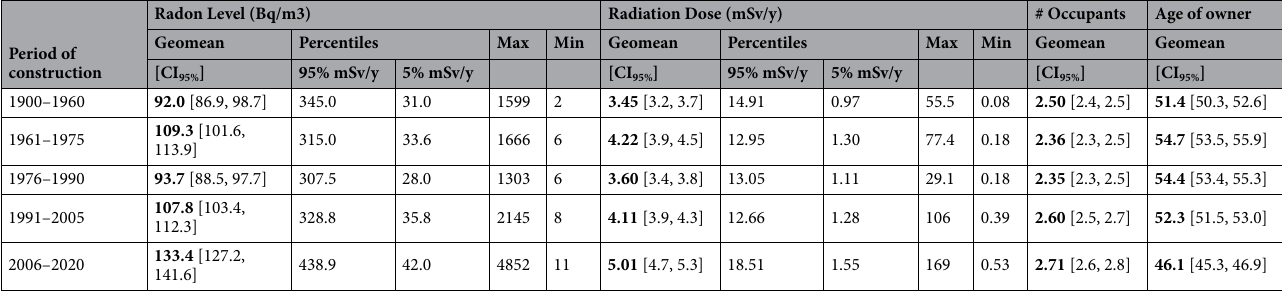
Table 1. Summary of North American radiation exposure from residential